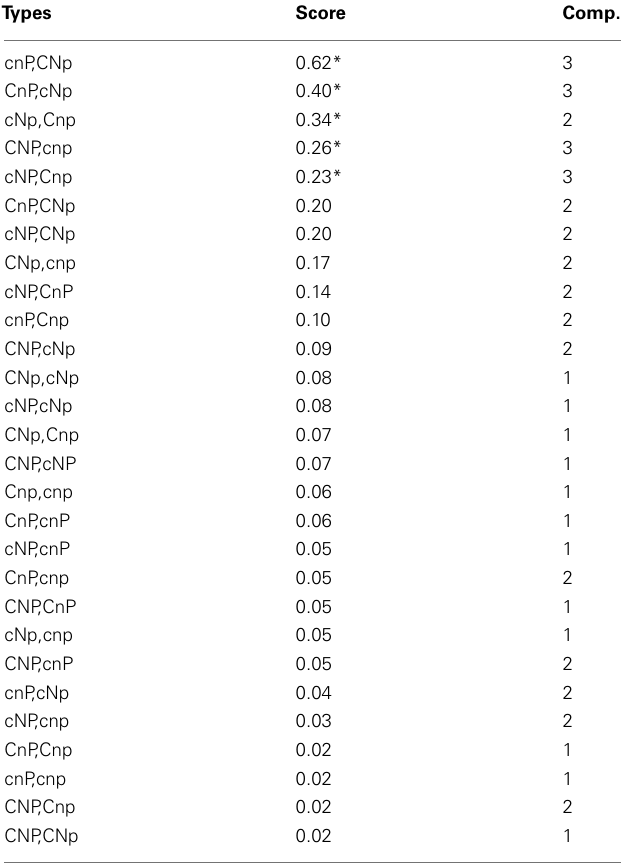
*Denotes statistical significance with Bonferroni correction at the 5 µ m